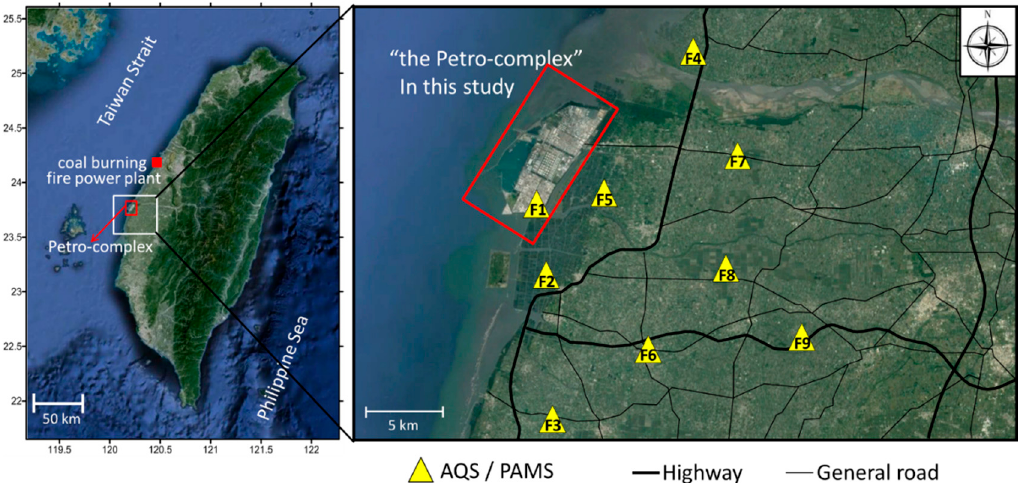
Figure 1. Area within a 20 km radius of the Petro-complex is dubbed the Petro-region, as indicated by the white box on the left panel, within which nine air quality stations (AQSs) and photochemical assessment monitoring stations (PAMSs) of site F1-F9 are deployed, as indicated by the yellow triangles. Red box indicates the campus of the Petro-complex.